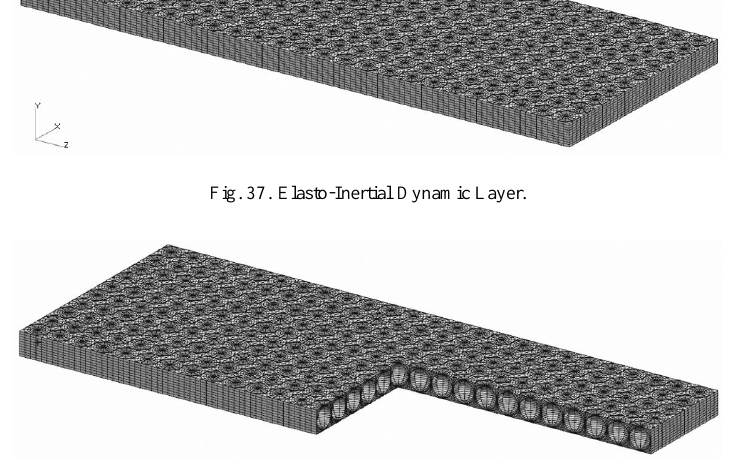
Fig. 38. Section view of the Elasto-Inertial Dynamic Layer.